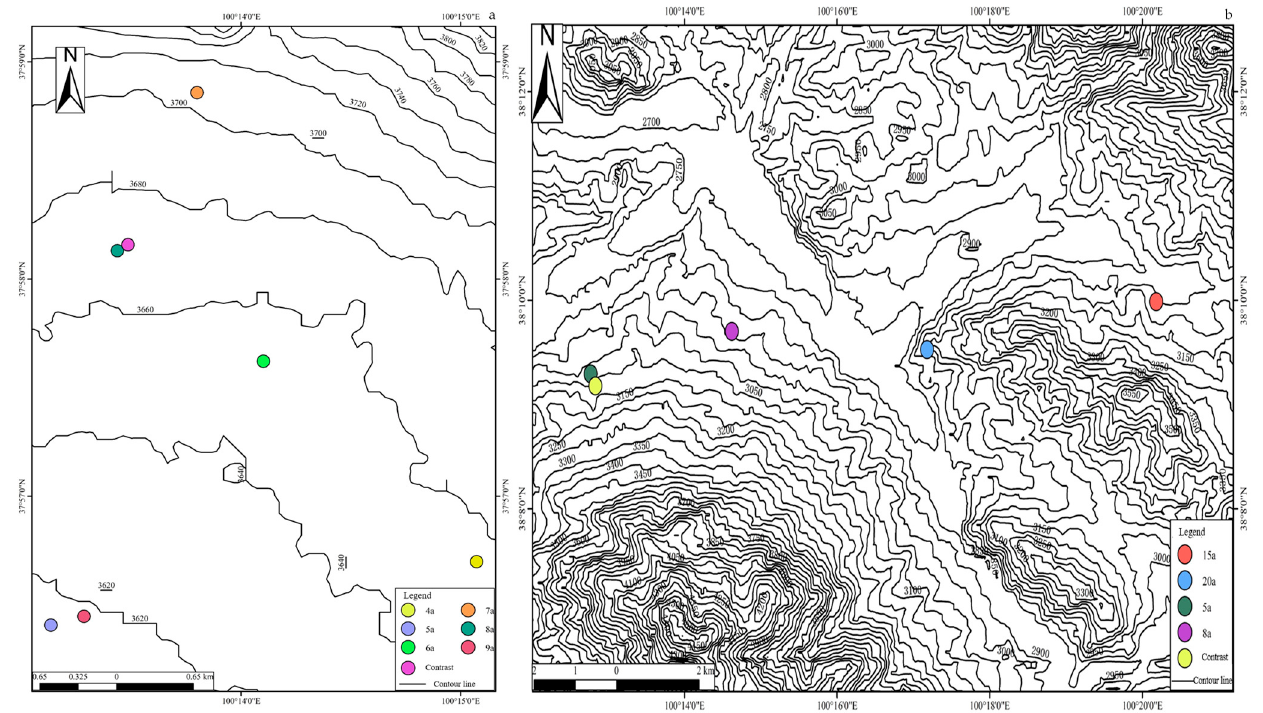
Figure 1. Sampling points for restoration of grasslands ( a ) and woodlands ( b ).